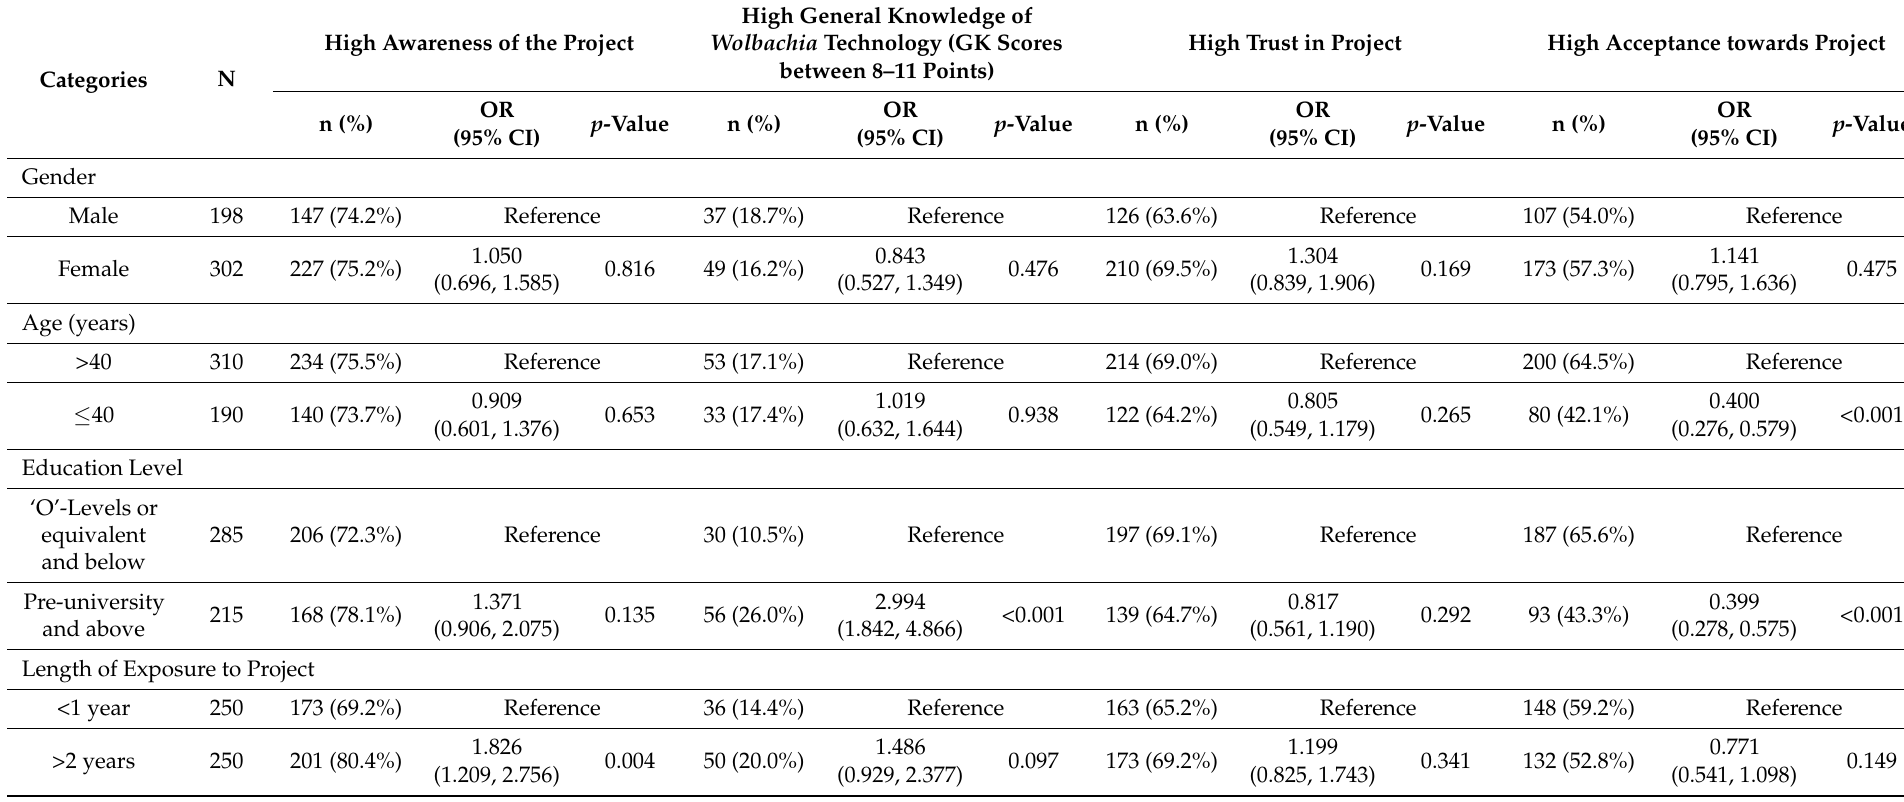
Table 6. Analysis of socio-demographic factors associated with high levels of awareness, knowledge, trust and acceptance towards the project. Each row presents select ORs from bivariate analysis (Pearson’s Chi-square